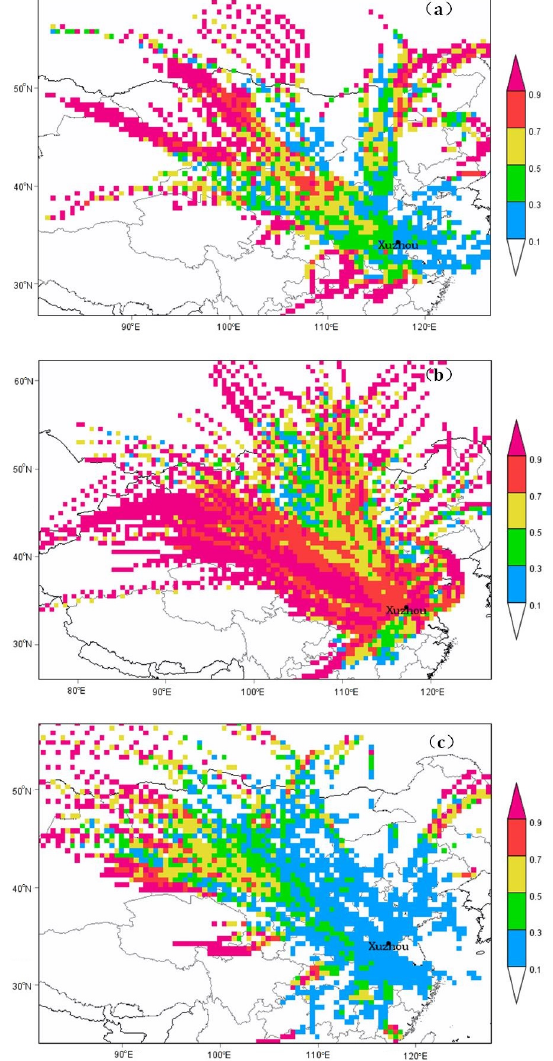
Figure 8. PSCF maps of EBC in Xuzhou for the ( a ) entire year, ( b ) heating season, and ( c ) nonheating season. Only back trajectories with hourly EBC concentrations larger than 3.00 × 10 3 ng/ m (cid:2871) were included.